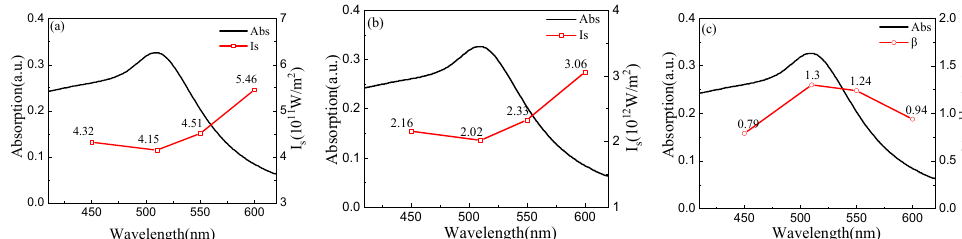
Figure 4. Dependence of saturation intensity and nonlinear absorption coefficient on wavelength. ( a ) Relationship between wavelength and saturated absorption intensity under 260 μ J energy excitation. ( b ) Relationship between wavelength and saturated absorption intensity under 760 μ J energy excitation. ( c ) Relationship between wavelength and saturated nonlinear absorption coefficient β .